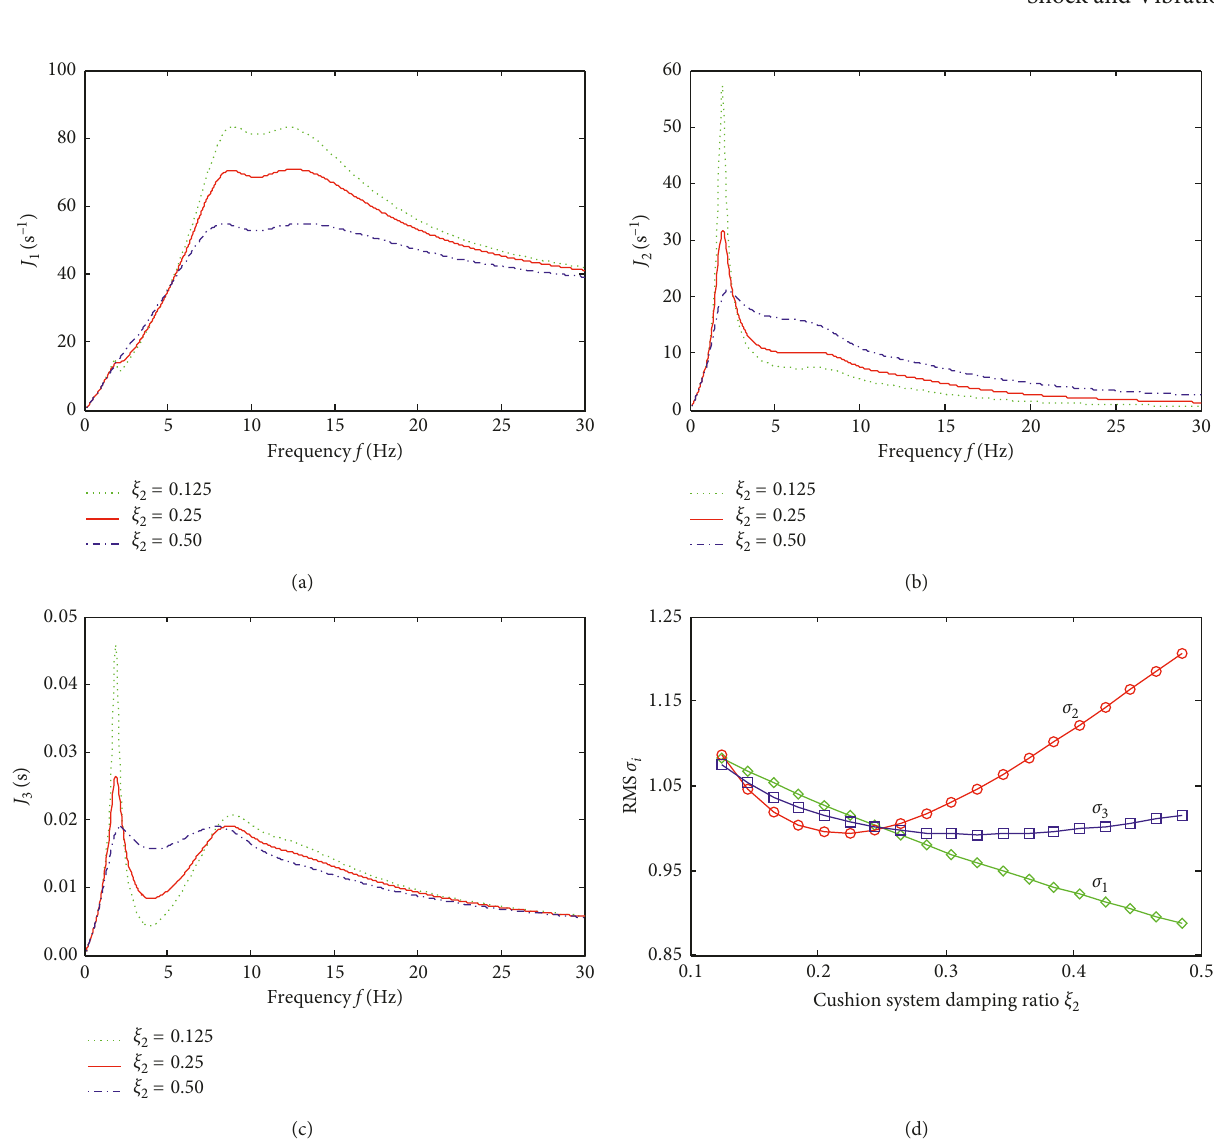
at different values of ξ 1 at different values of ξ 3